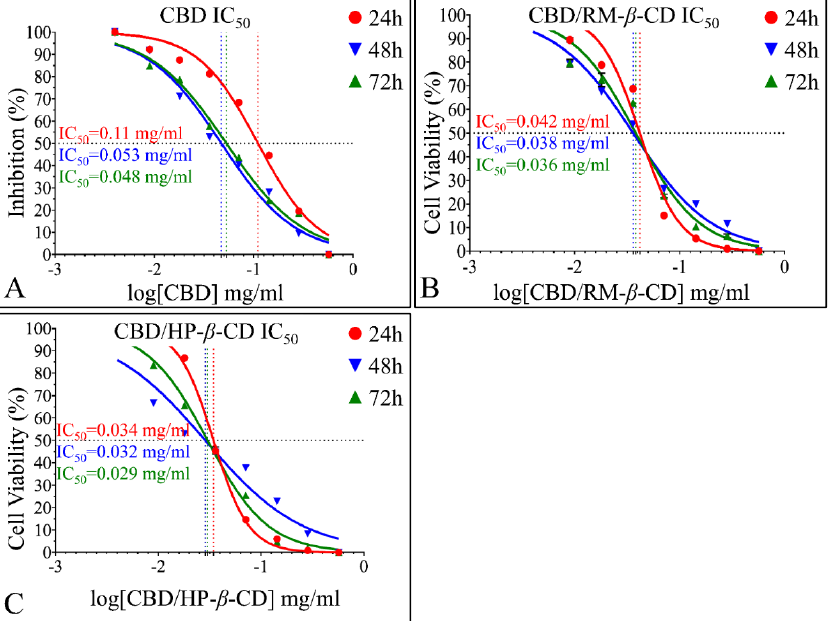
Figure 14. Calculation of IC 50 of CBD and its inclusion complexes on TE671 cells. ( A ) IC 50 values were calculated to be 0.11 mg/mL ( R 2 = 0.98) at 24 h, 0.053 mg/mL at 48 h ( R 2 = 0.98), and 0.048 mg/mL at 72 h ( R 2 = 0.98) for the CBD/DMSO inclusion complex. ( B ) The IC 50 for the CBD/RM- β -CD inclusion complex was 0.042 mg/mL at 24 h ( R 2 = 0.97), 0.038 mg/mL at 48 h ( R 2 = 0.98), and 0.036 mg/mL at 72 h ( R 2 = 0.98). ( C ) The IC 50 for the CBD/HP- β -CD inclusion complex was 0.034 mg/mL at 24 h ( R 2 = 0.99), 0.032 mg/mL at 48 h ( R 2 = 0.99), and 0.029 mg/mL at 72 h ( R 2 = 0.94). Microscopy Examination of CBD Effects on A172 Cells